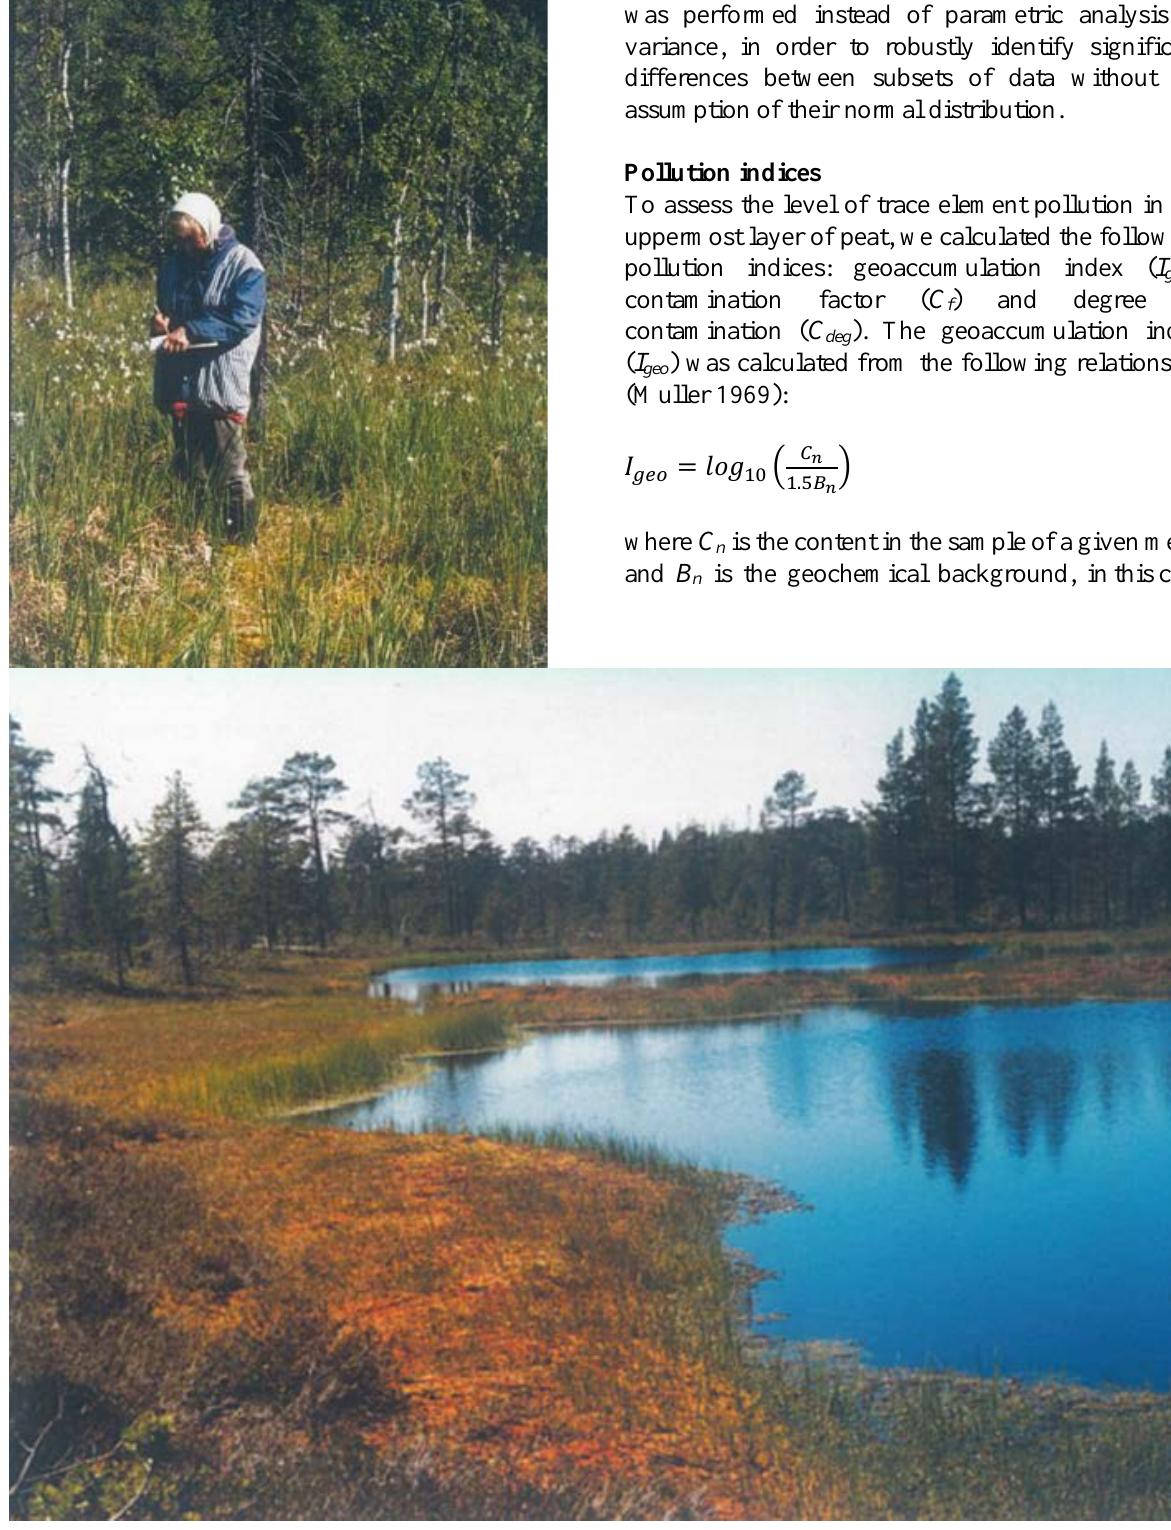
Figure 3. Above: Professor M. Botch working on a transitional mire with sparse forest (No. 9 in Figure 2) during the 1996 Solovetsky expedition. Below: floating vegetation mat at a raised bog site (No. 21 in Figure 2). A few herb species are visible among the (mainly Sphagnum ) mosses. P hotos: S.